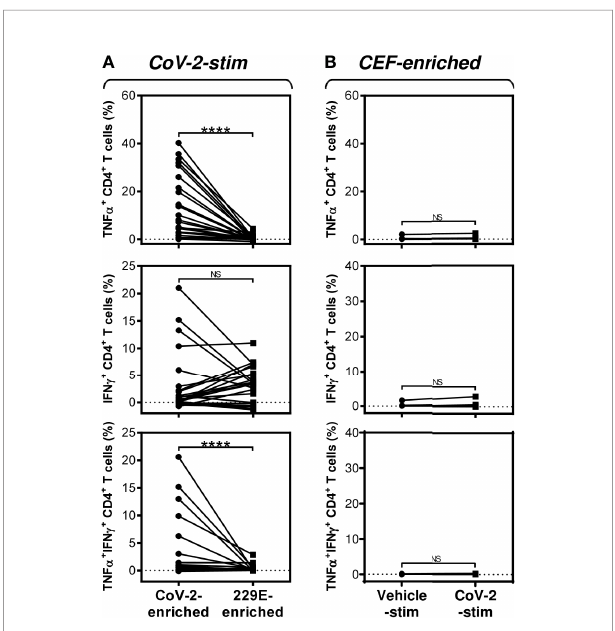
FIGURE 3 | SARS-CoV-2/HCoV-229E reactivity and SARS-CoV-2 cross- reactivity of CD4 + T cells in cell cultures enriched with SARS-CoV-2- or HCoV-229E-spike glycoprotein peptide pools (A) The SARS-CoV-2 (CoV-2- enriched) or HCoV-229E (229E-enriched) peptide pool-enriched cell cultures were stimulated with SARS-CoV-2 peptide pool and differences in the proportions of TNF a -, IFN g -, or TNF a /IFN g -producing CD4 + T cells between both groups evaluated. (B) The CEF peptide pool-enriched cell cultures (CEF- enriched) were stimulated with no peptide (Vehicle-stim) or SARS-CoV-2 peptide pool (CoV-2-stim) and differences in the proportions of TNF a -, IFN g -, or TNF a /IFN g -producing CD4 + T cells between both groups evaluated. In (A, B) , signi fi cances of differences among the groups are indicated (**** P <0.0001, A: n = 25 donors (11 healthy male donors and 14 HR metastatic PCa patients), B: n = 10 donors (2 healthy male donors and 8 HR metastatic PCa patients), Wilcoxon matched-pairs signed-ranks test). P >0.05 were considered nonsigni fi cant